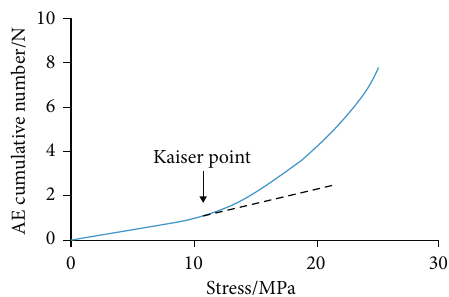
Figure 2: Identi fi cation of Kaiser e ff ect points by AE cumulative parameter sudden increase point